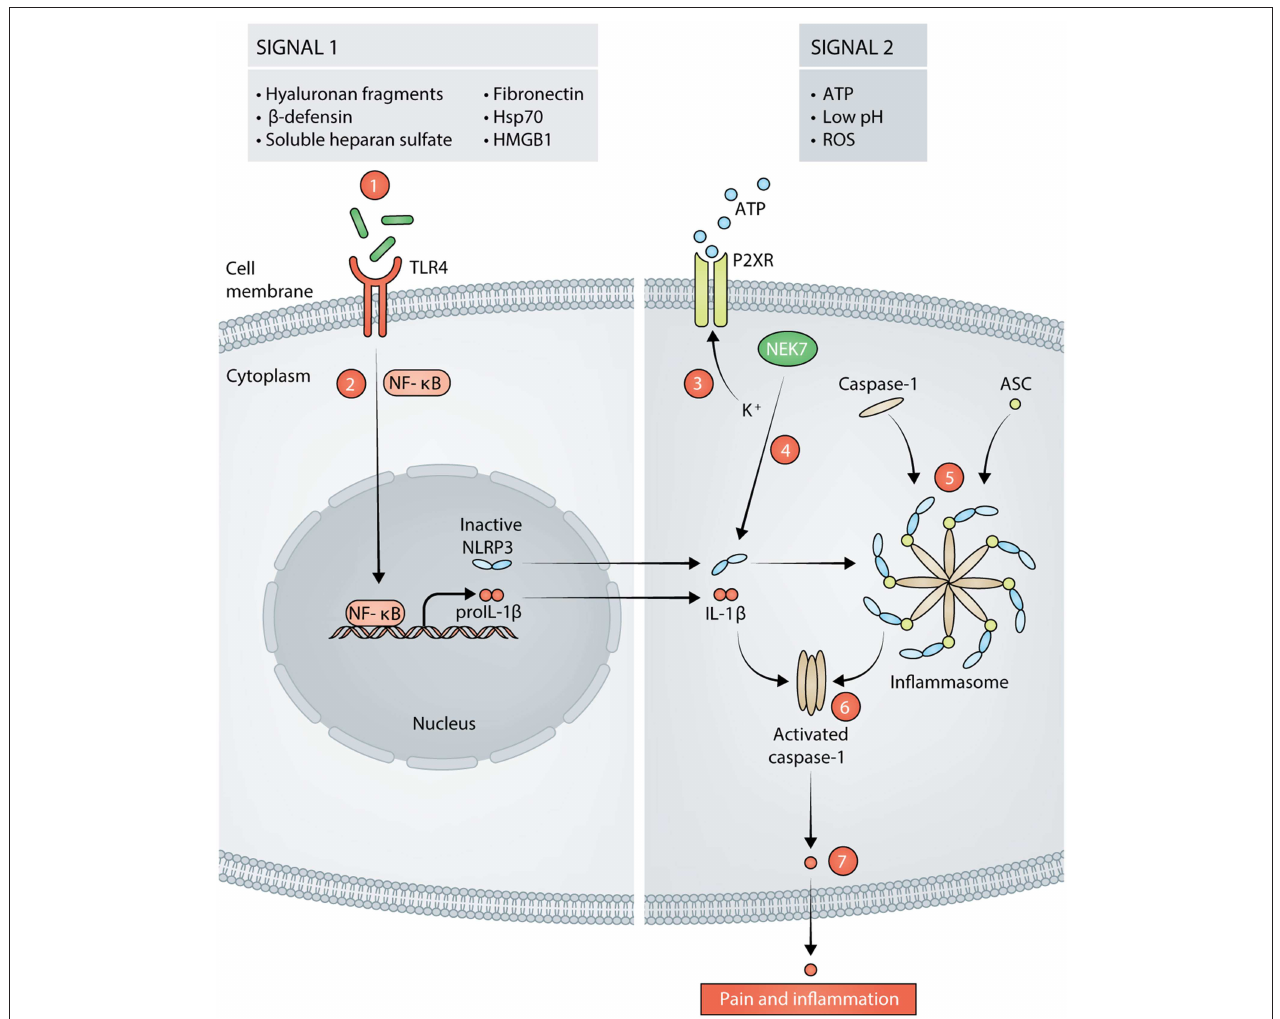
FIGURE 1 | Signals in response to tissue damage activate the NLRP3 inflammasome (signal 1 and signal 2). Hyaluronan fragments, β -defensins, soluble heparan sulfate, fibronectin, 70 kilodalton heat shock proteins (Hsp70), and high mobility group box 1 (HMGB1) are released following incision and act as signal 1 for NLRP3 by stimulating TLR4 on the cell membrane (1). Stimulation of TLR4 leads to activation of NF- κ B and transcription of proIL-1 β and NLRP3 (2). Adenosine Triphosphate (ATP), reactive oxygen species (ROS), and low pH can then act as signal 2 for NLRP3. ATP acts on purinergic ion channel receptors (P2XR) such as P2X7 or P2X4 which results in potassium (K + ) efflux from the cell (3). The decrease in K + concentration is sensed by NIMA Related Kinase 7 (NEK7). NEK7 associates with inactive NLRP3, thereby activating it (4). Active NLRP3 then forms a scaffold with caspase-1 and apoptosis-associated speck-like protein containing a CARD (ASC), thus, forming the inflammasome (5). Caspase-1 is activated by the formation of the inflammasome (6). Activated caspase-1 cleaves proIL- into mature IL-1 β that is released from the cell and subsequently, results in pain and inflammation